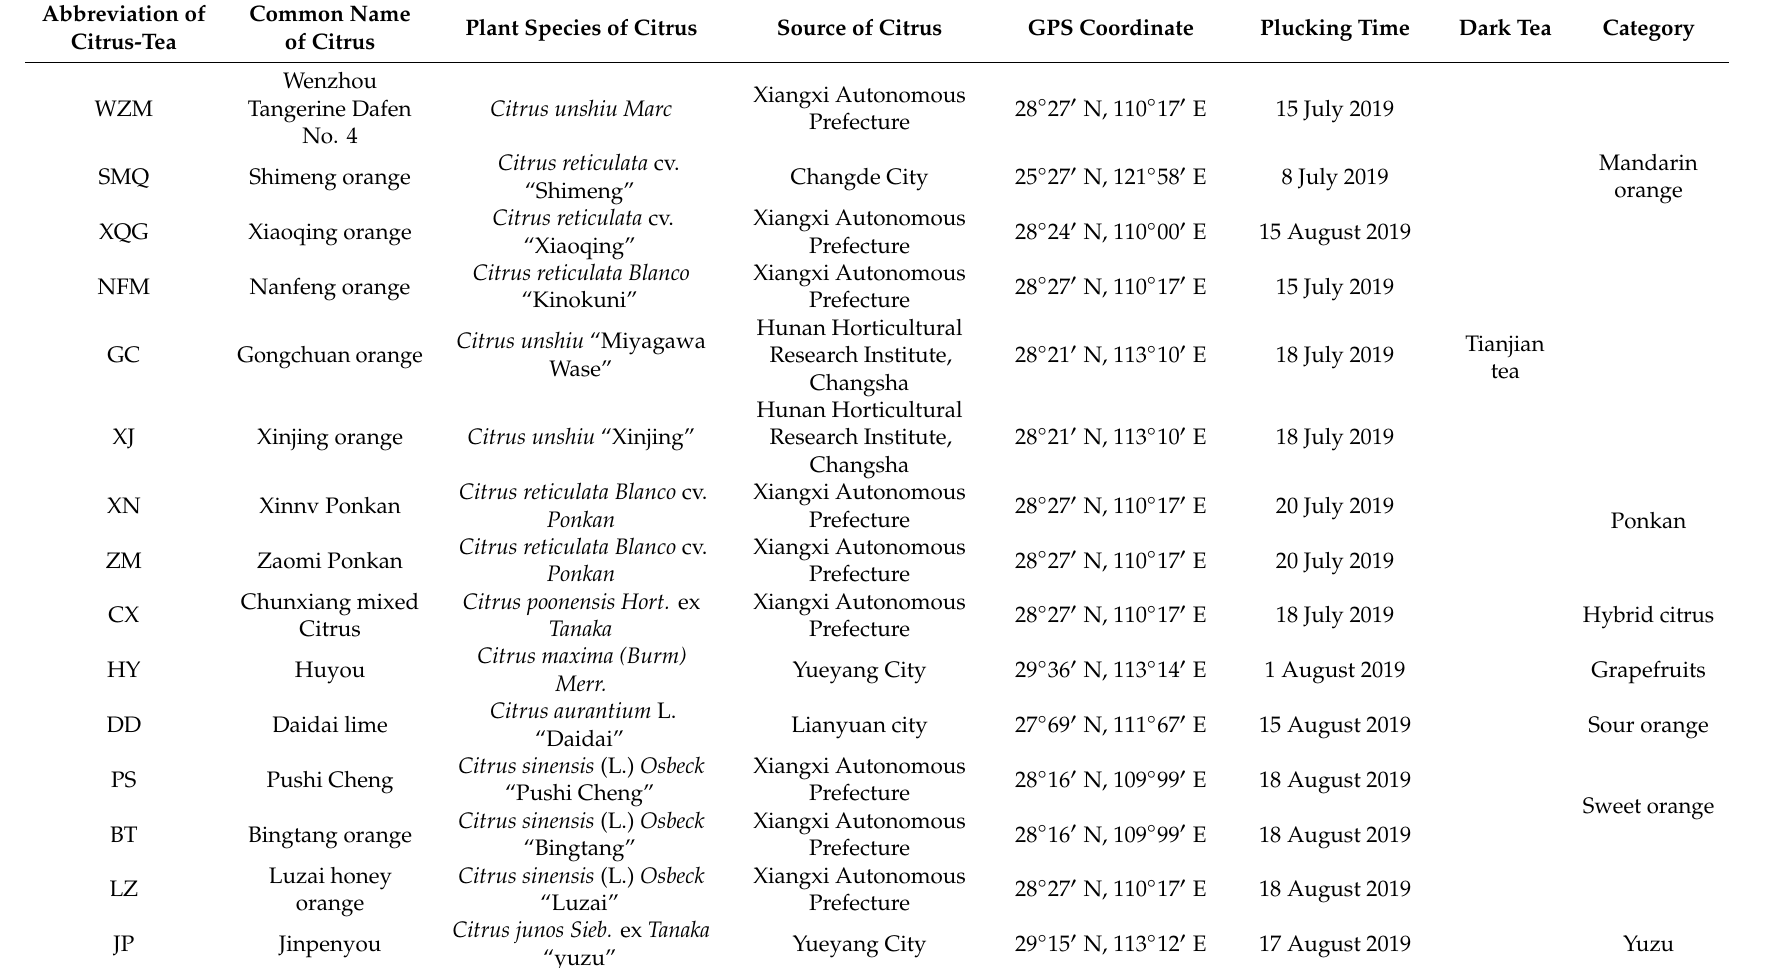
Table 2. Citrus tea information